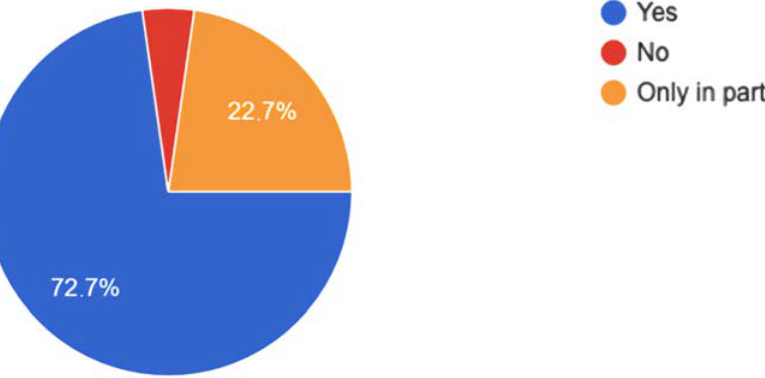
Figure 7. Perception of the usefulness of mindfulness practice during confinement and situations derived from the syndemic.